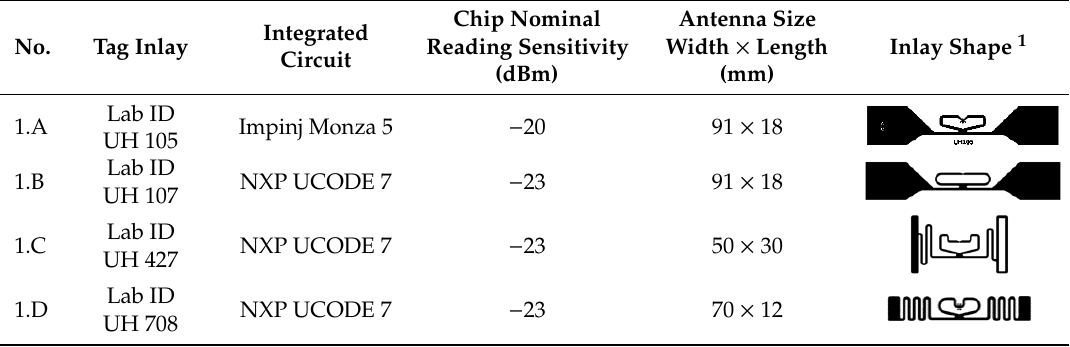
Table 2. Technical specifications of the Dual Frequency tags used on both test benches in Figures 2 and 3. No.